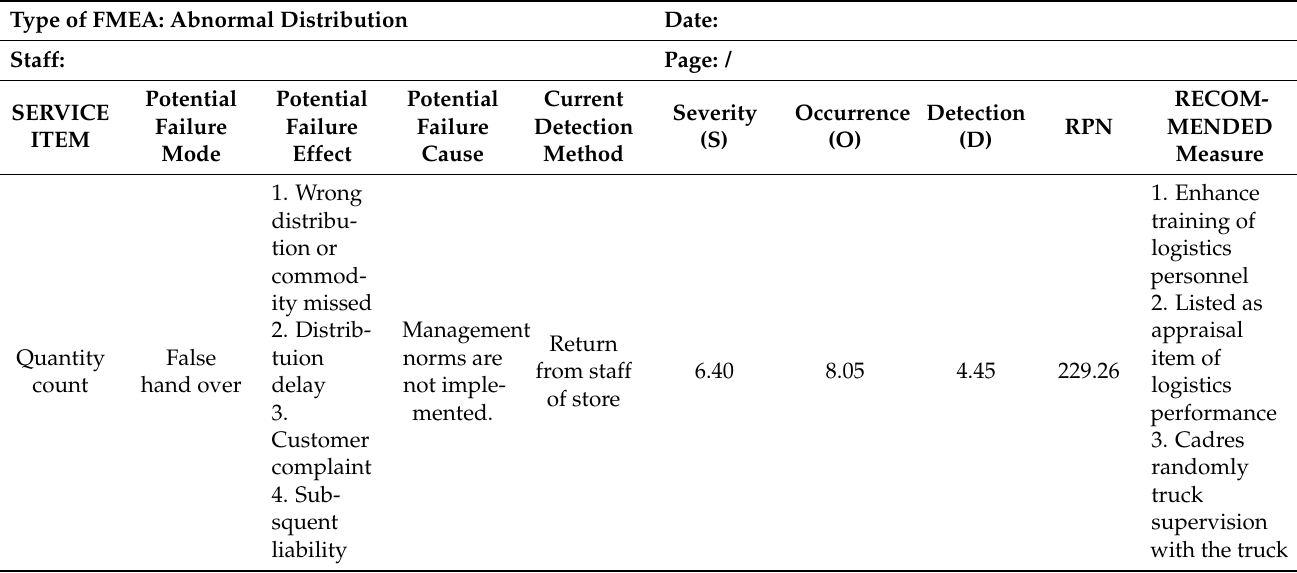
Table 3. Example of abnormal distribution failure mode of logistics (F10-3).